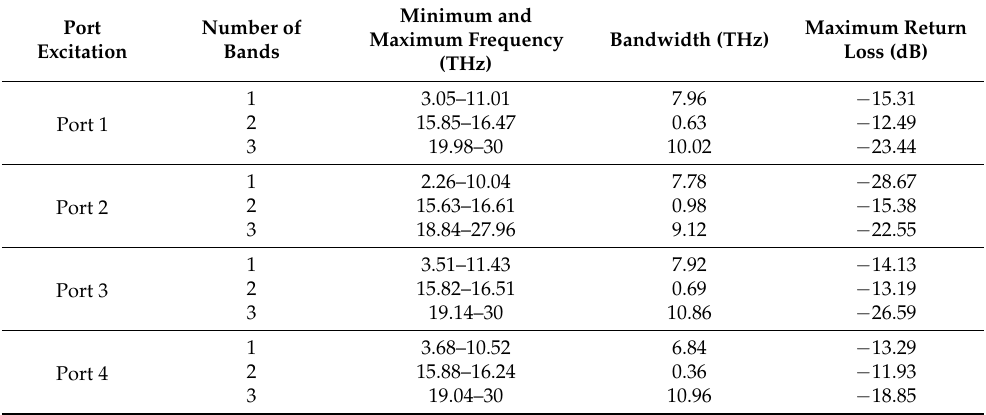
Figure 3. Calculated S-parameters for the Type-1 antenna (2 × 2 structure) by considering ( a ) port-3 and ( b ) port-4 as exciting ports. Table 2. Comparative analysis of type 1 antenna for individual port excitation.